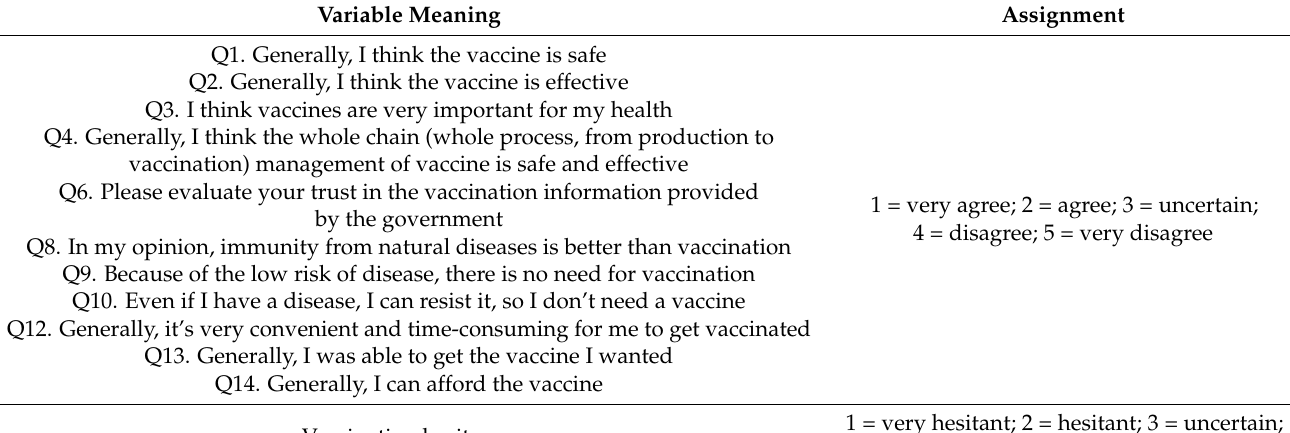
Table 1. Variables assignment for the structural equation model of a vaccine.